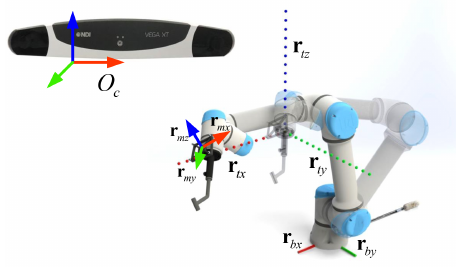
Figure 4. Movement trajectories of the reference frame for identifying the three column vectors, r tx , ˆR . During the movement, we keep the orientation of the flange r ty , and r tz , of the rotation matrix c b unchanged under the observation of the tracking